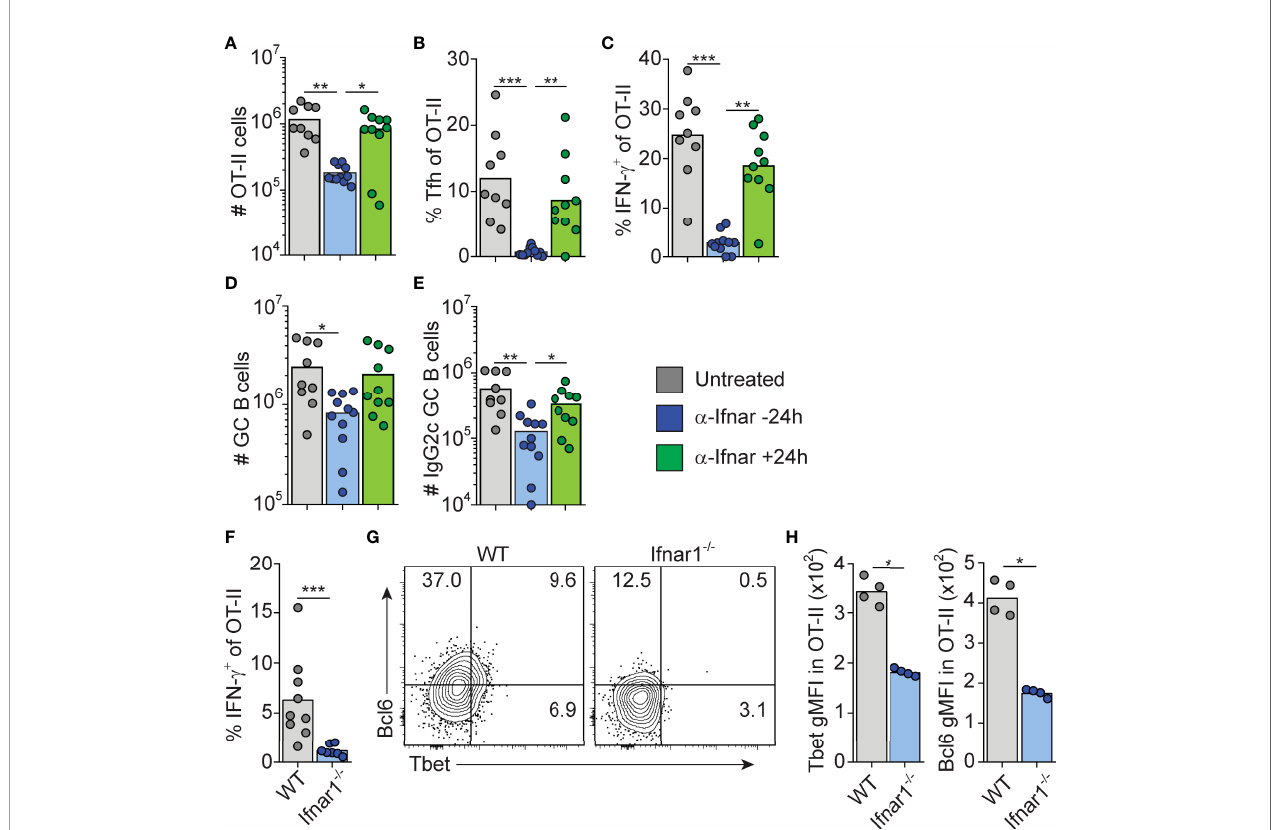
FIGURE 4 | Type I IFN signaling drives Tfh and Th1 cell differentiation within the fi rst 24 hrs after immunization. (A – E) WT mice transferred with 50000 OT-II cells were treated i.p. with 1 mg anti-IFNAR1 or isotype control mAb 16 hrs before or 24 hrs after immunization with OVA/pI:C. Splenocytes were analyzed by fl ow cytometry 8 dpi. (A) Number of OT-II cells. (B) Percentage of Tfh cells of total OT-II cells. (C) Percentage of IFN- g + cells of total OT-II cells. (D) Number of GC B cells. (E) Number of IgG2c + GC B cells. (F – H) WT and Ifnar1 -/- mice were transferred with 500 000 OT-II cells and donor cells in spleen analyzed by fl ow cytometry 3 days after immunization with OVA/poly I:C. (F) Percentage of IFN- g + cells of total OT-II cells. (G – H) Analysis of T-bet versus Bcl6 expression with representative contour plots (G) and geometric mean fl uorescence intensity (GMFI) for T-bet and Bcl6, respectively. Individual mice and mean values (A – F) or representative results (G – H) of three independent experiments are shown. *p ≤ 0.05, **p<0.01 and